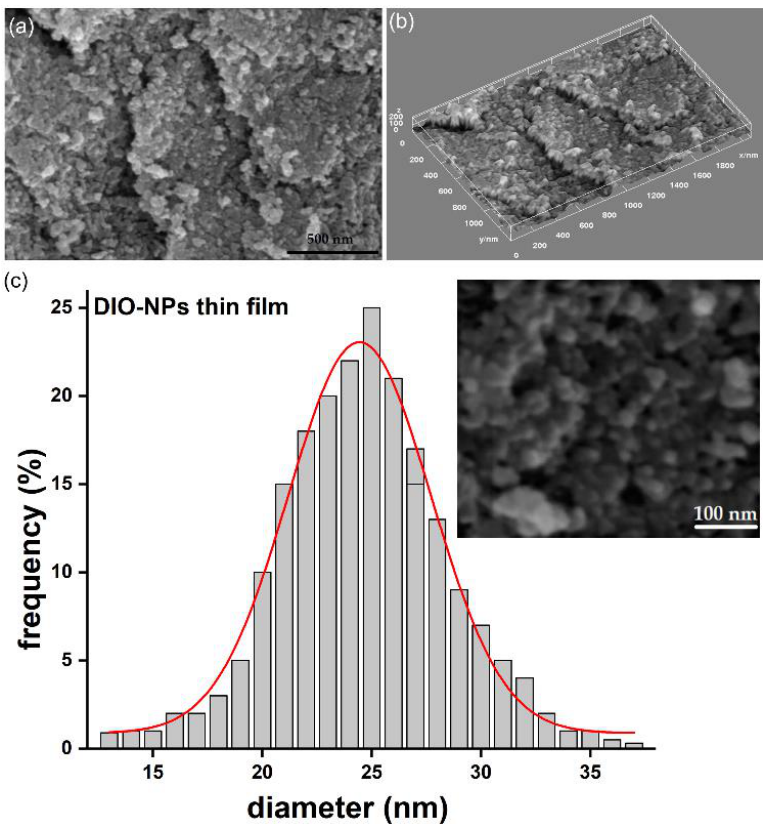
Figure 5. SEM image of DIO-NPs layers at 10,000 × magnification ( a ), 3D surface plot of SEM image of DIO-NPs layers at 10,000 × magnification ( b ) and size distribution of particles from SEM image-inset ( c ).